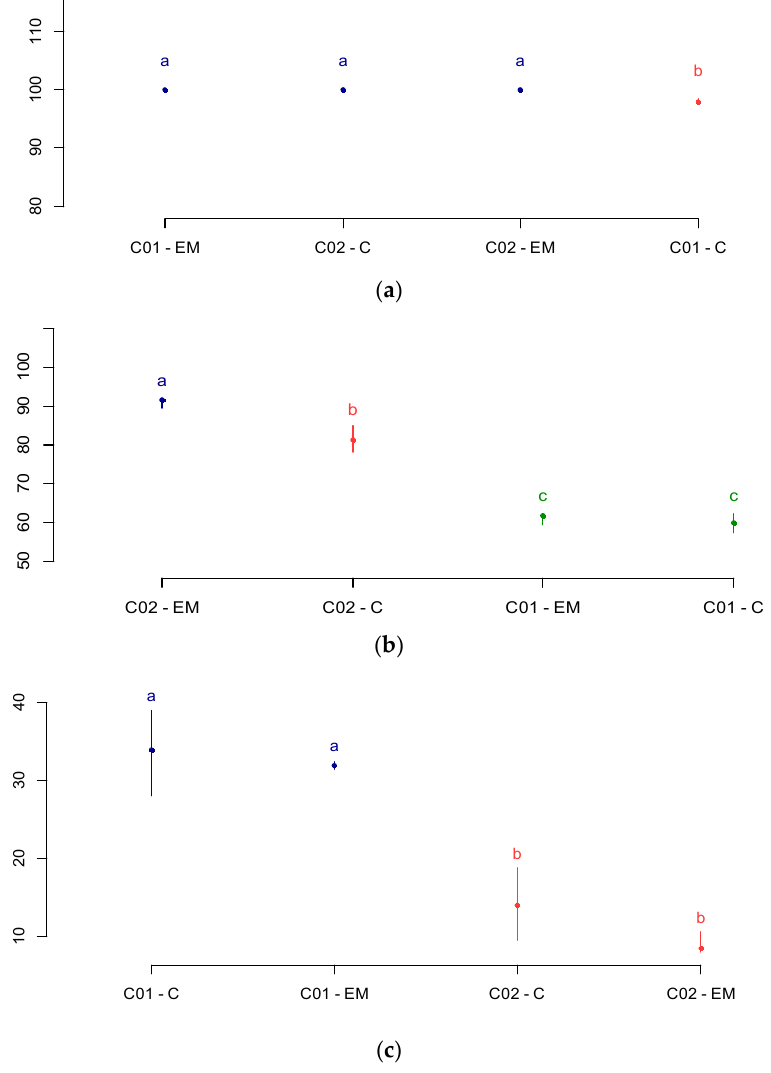
Figure 2. Germination pattern test (GPT). ( a ) Total germination; ( b ) normal seedlings in the first count test; ( c ) abnormal seedlings. C—control group; EM—electromagnetic bio stimulation (magneto- priming). Average followed by the same later end color do not differ significantly by the Fisher’s LSD